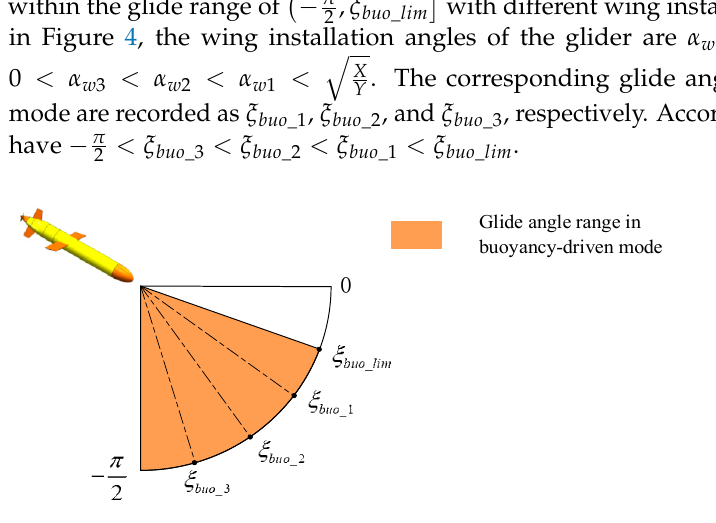
Figure 4. Glide angle range in buoyancy-driven mode.